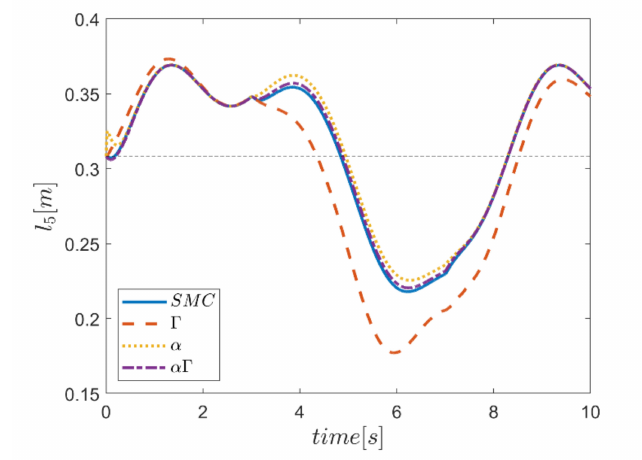
Figure 60. Comparison of the length of the fifth actuator.